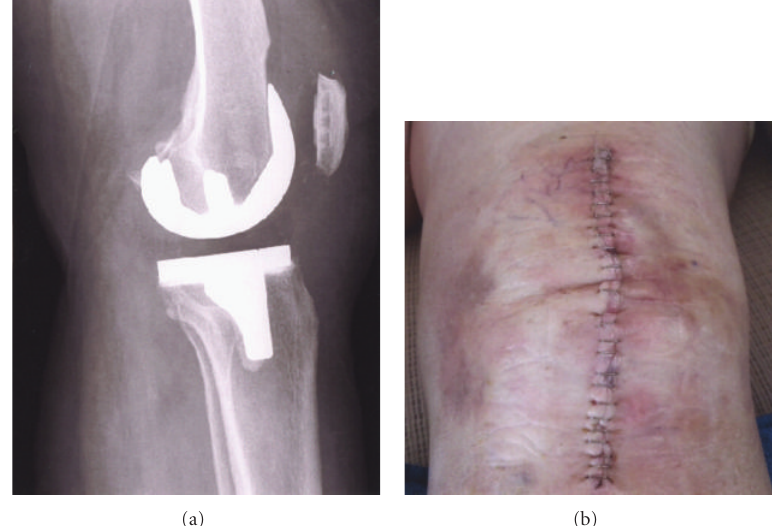
Figure 4: X-ray image (a) and incision-suture photograph for total knee replacement (b) (Courtesy of Patricia Murr).